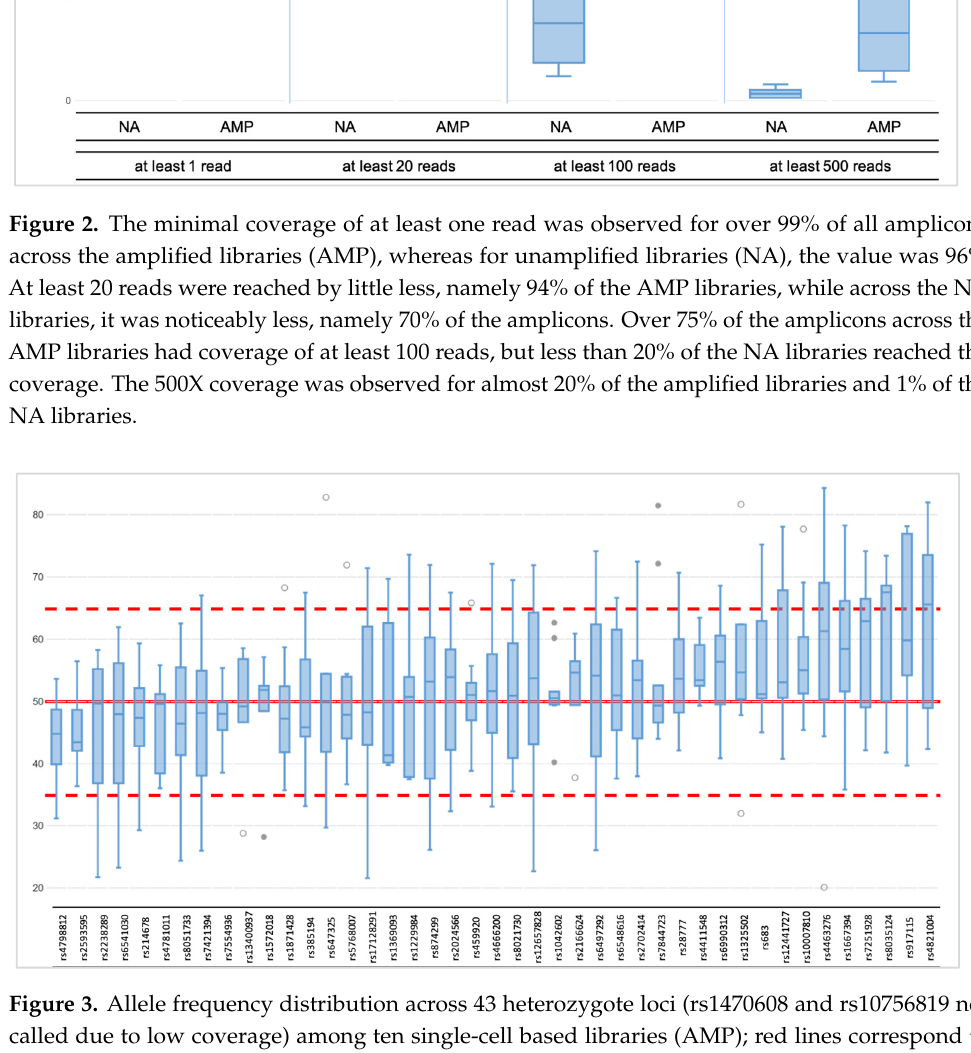
Figure 3. Allele frequency distribution across 43 heterozygote loci (rs1470608 and rs10756819 not called due to low coverage) among ten single-cell based libraries (AMP); red lines correspond to expected (50%), upper (65%), and lower (35%) thresholds.